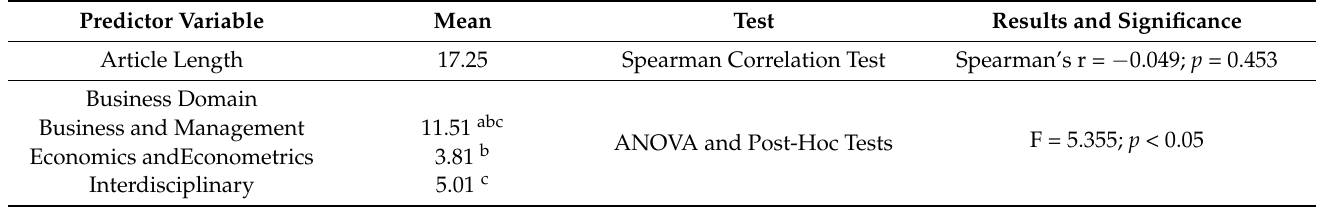
Table 3. Results of association tests between article-related variables and number of